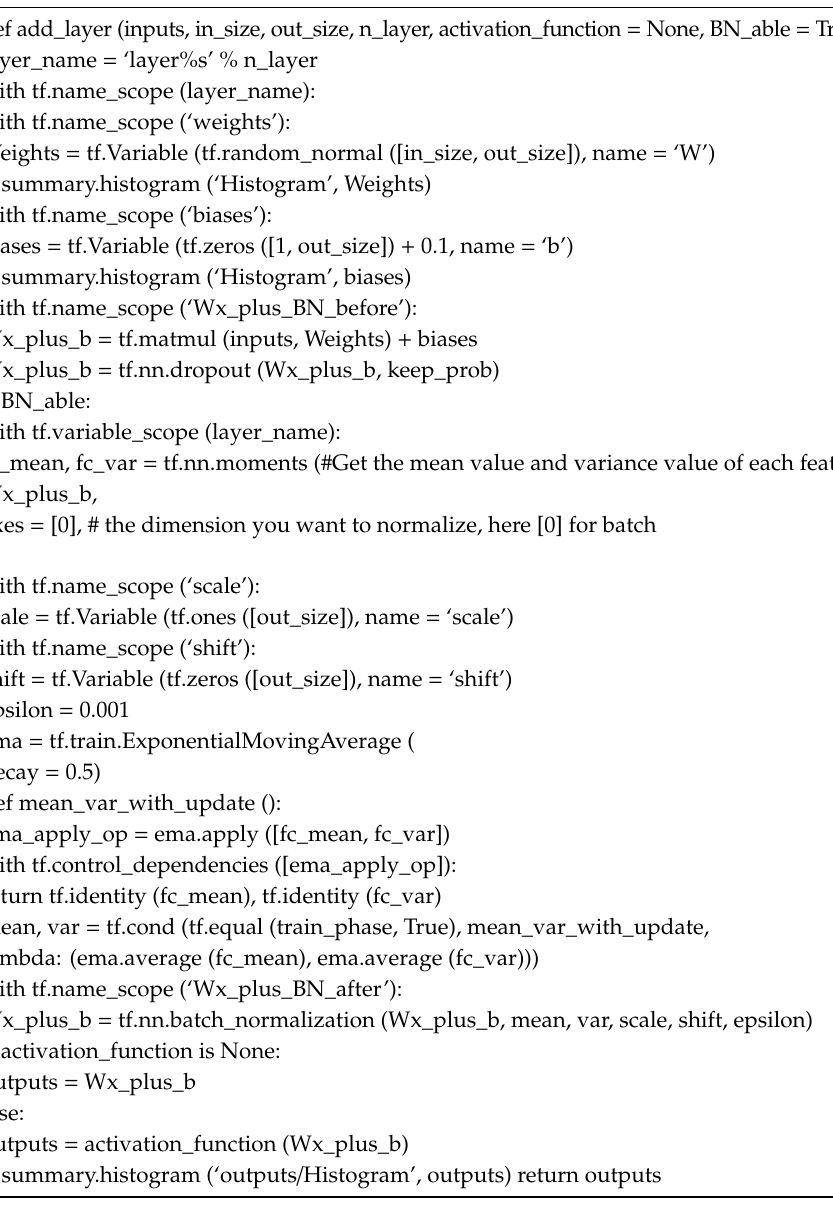
Algorithm A1. Script of function